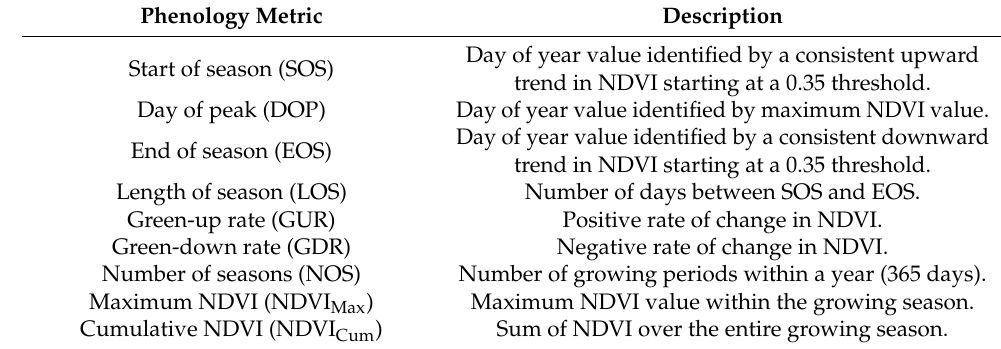
Table 1. Description of phenology metrics collected in this study using a modified half-max approach with a threshold of 0.35. Phenology Metric Description Day of year value identified by a consistent upward Start of season (SOS)